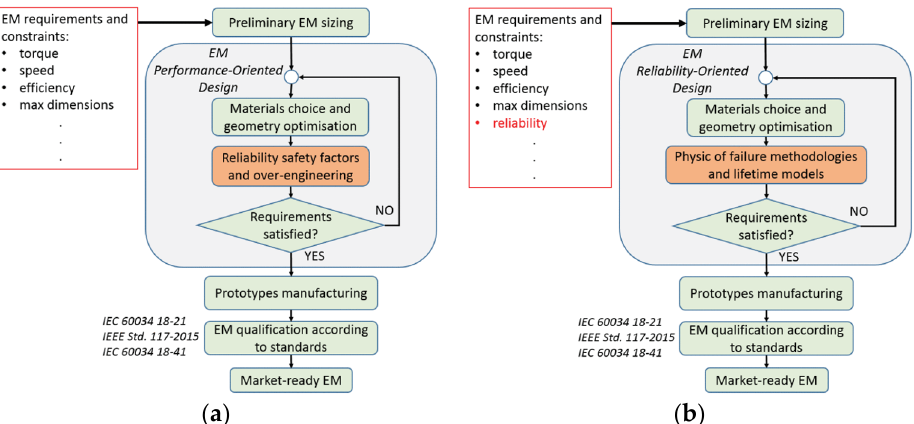
Figure 1. Flowchart of the two machine design strategies: ( a ) performance-oriented design; ( b ) reliability-oriented design.